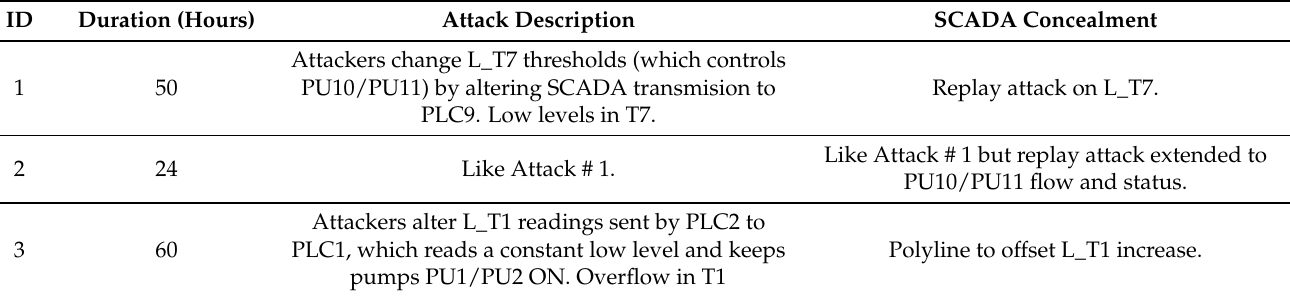
Table 2. Attacks featured in Training dataset 2